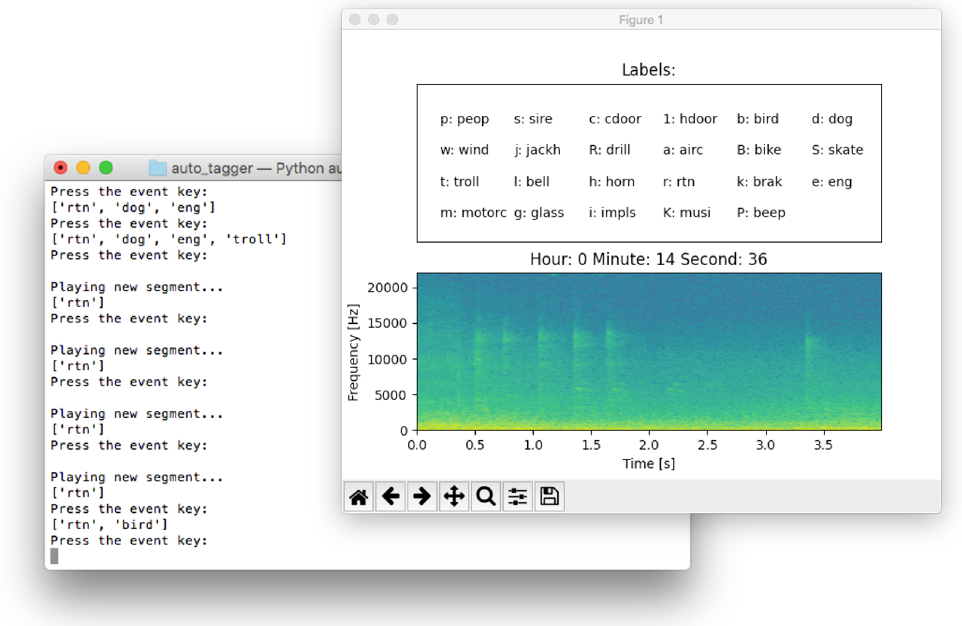
Figure 2. Screenshot of the developed python script. The screen on the background ( left ) records the keystrokes. The screen on the foreground ( right ) shows the information of the current window and a legend with the correspondences between keys and